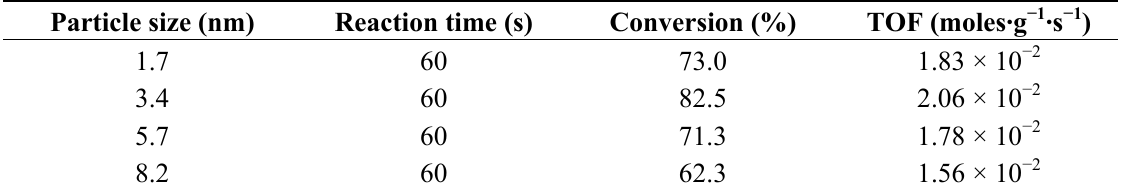
Table 1. Gold particle size and the corresponding TOF for the 4-NP